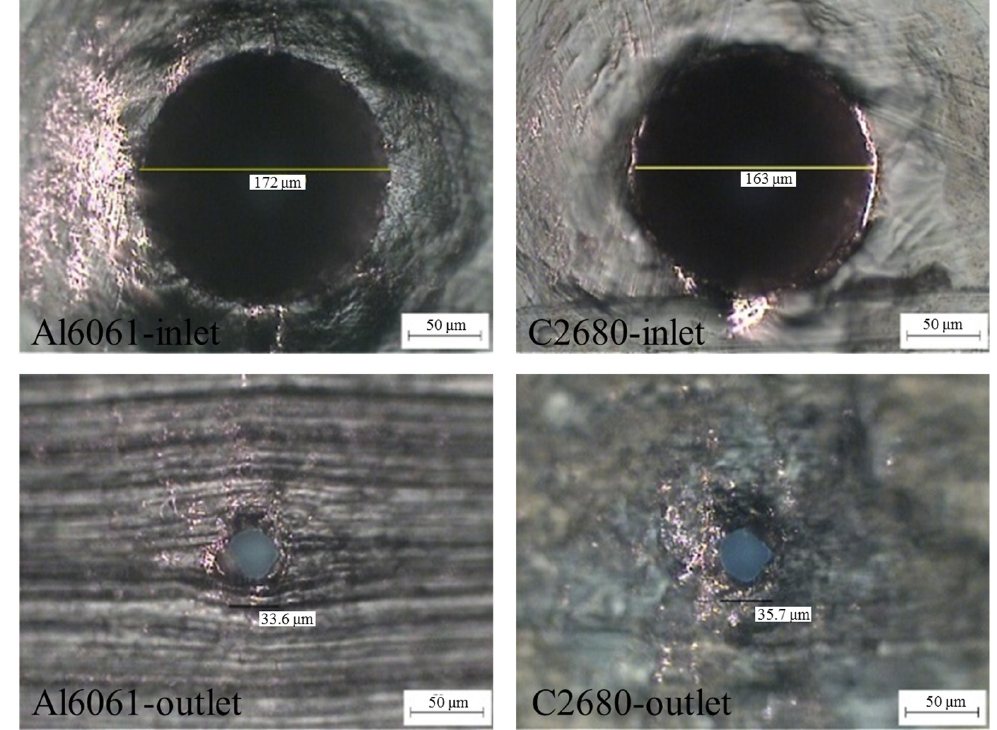
Figure 10. Optical Microscope (OM) images of micro stamping hole morphology ( Z = 380 μ m). Scale bars = 50 μ m.